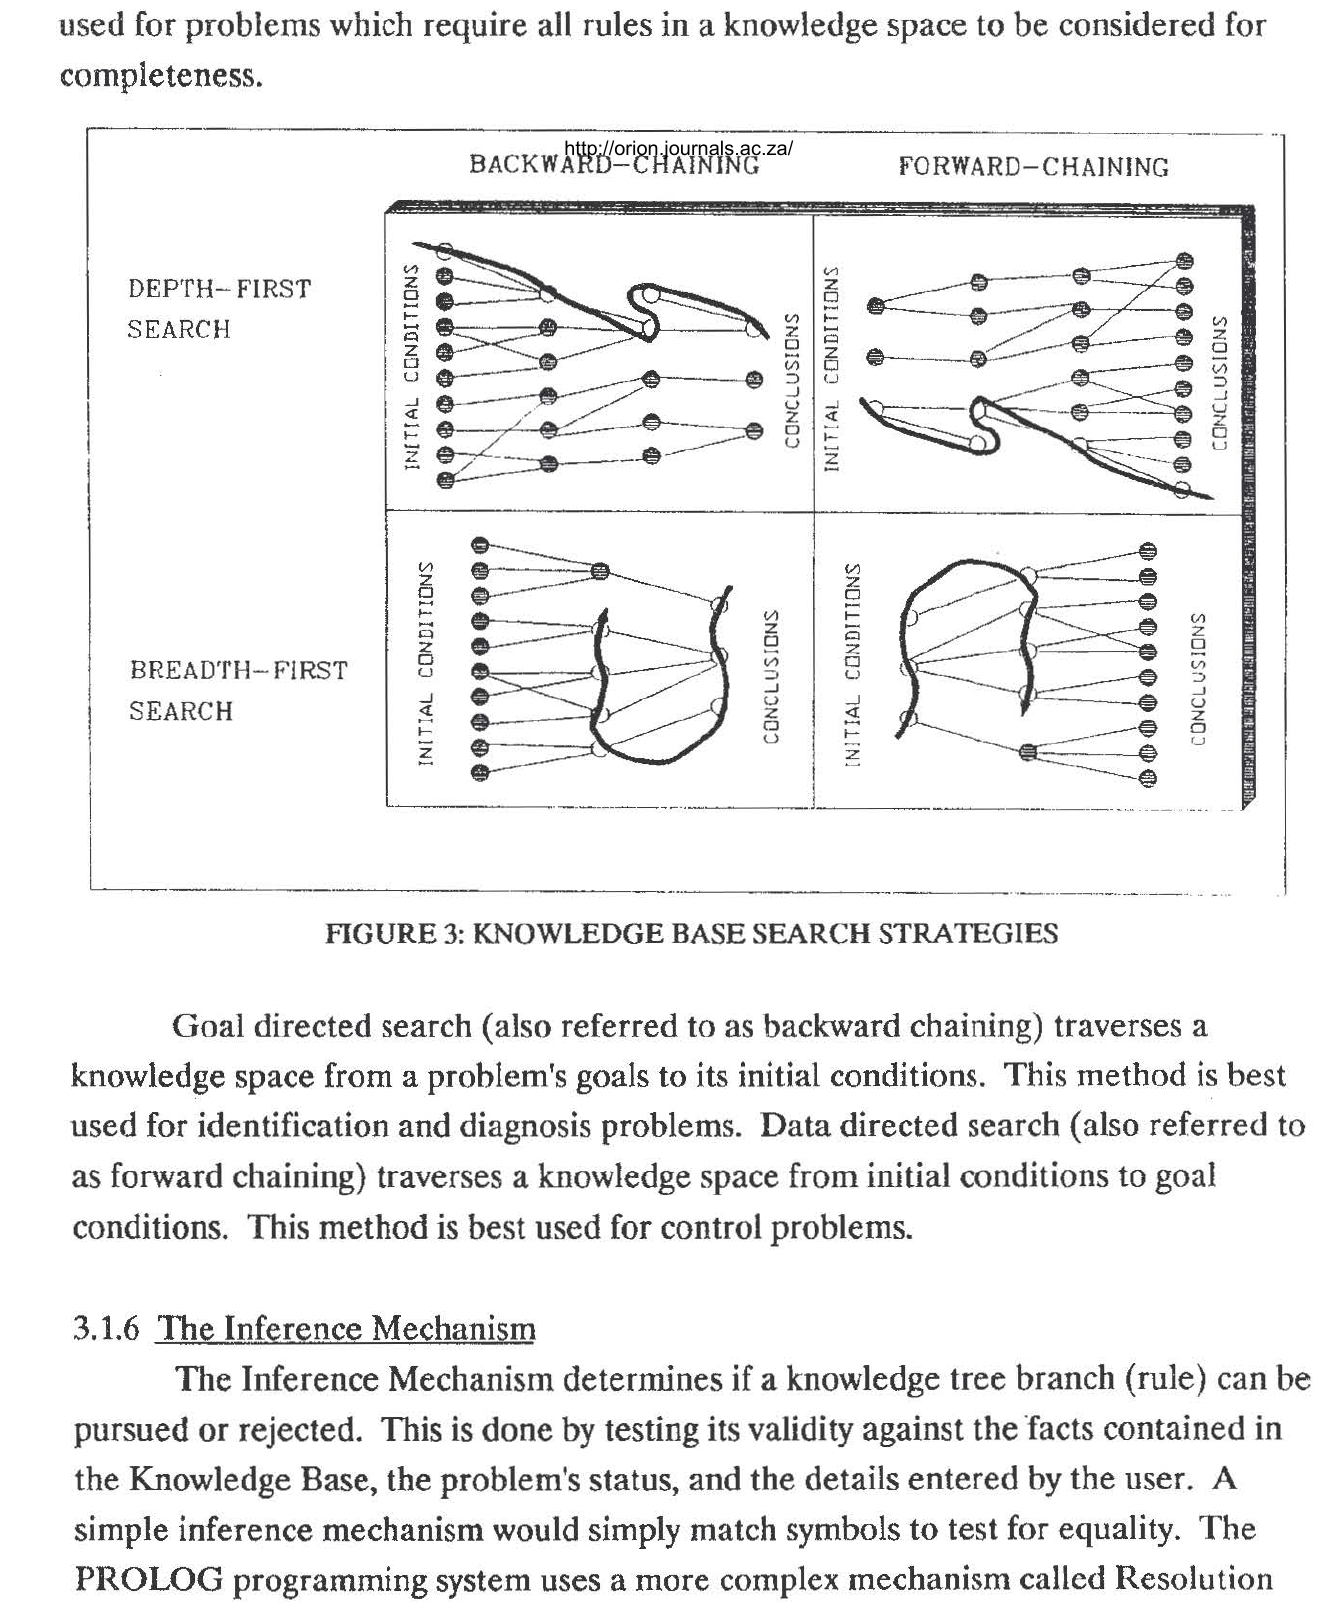
FIGURE 3: KNOWLEDGE BASE SEARCH